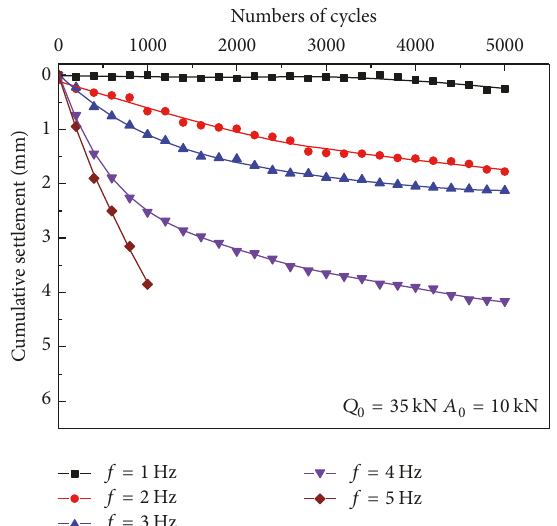
Figure 7: Cumulative settlement of X-section pile with variable loading frequencies.